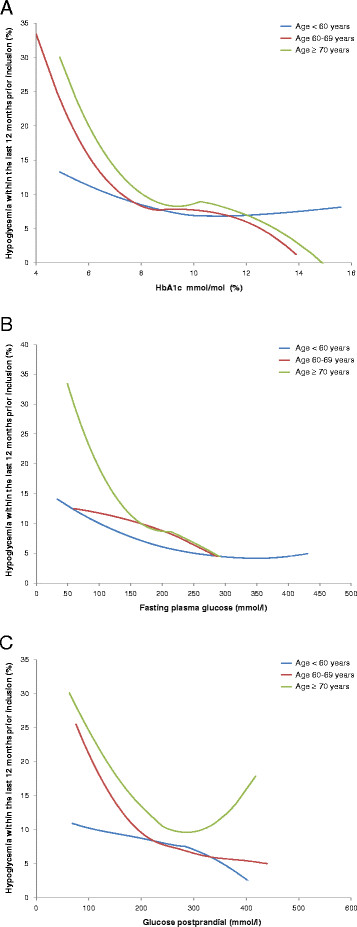
HbA1c (A); Fasting plasma glucose (B); Postprandial plasma glucose (C) and anamnestic hypoglycemia (within 12 months prior to baseline).Legend: none.